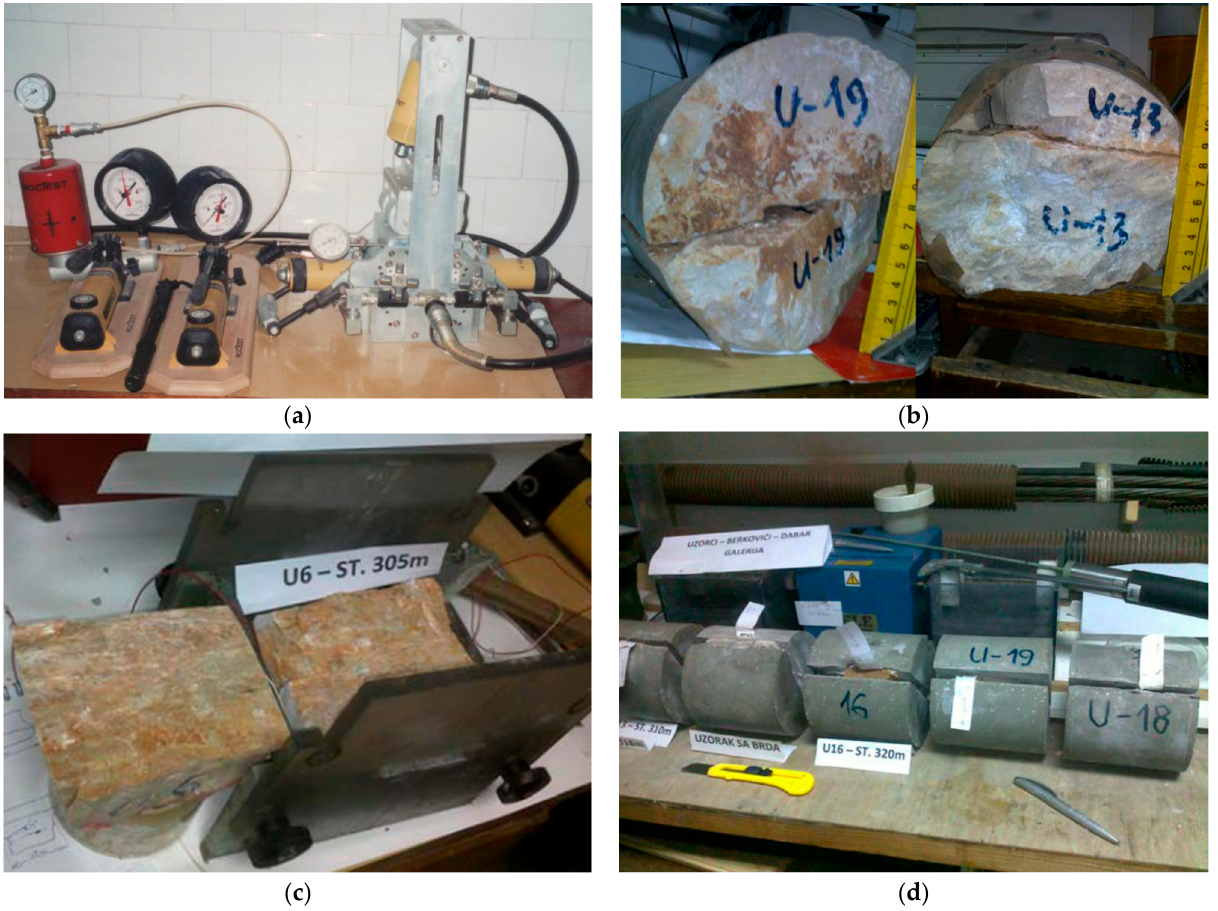
Figure 5. Procedure for shear testing along discontinuities: ( a ) shear device used for testing; ( b ) engineering–geological inspection and evaluation of joint samples; ( c ) placing of samples in mould prior to cementing; and ( d ) cemented samples prepared for testing [28].